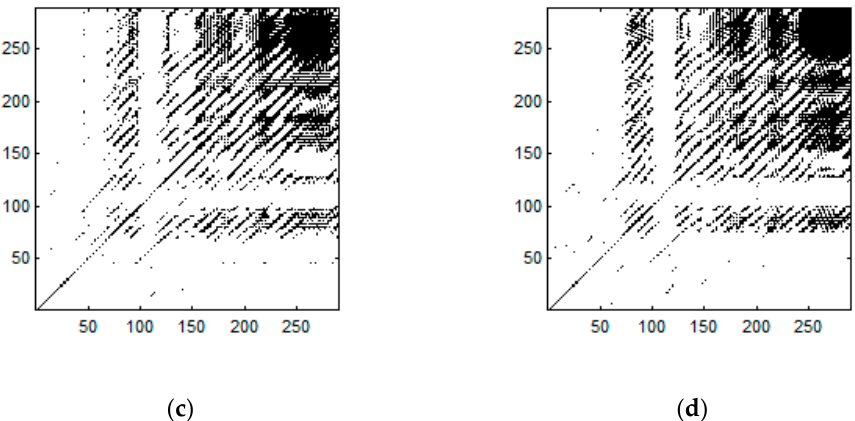
Figure 12. RPs of the second half of backscattered signals of defect areas with different diameter: ( a ) 0 mm; ( b ) 0.5 mm; ( c ) 0.7 mm; and, ( d ) 1 mm.